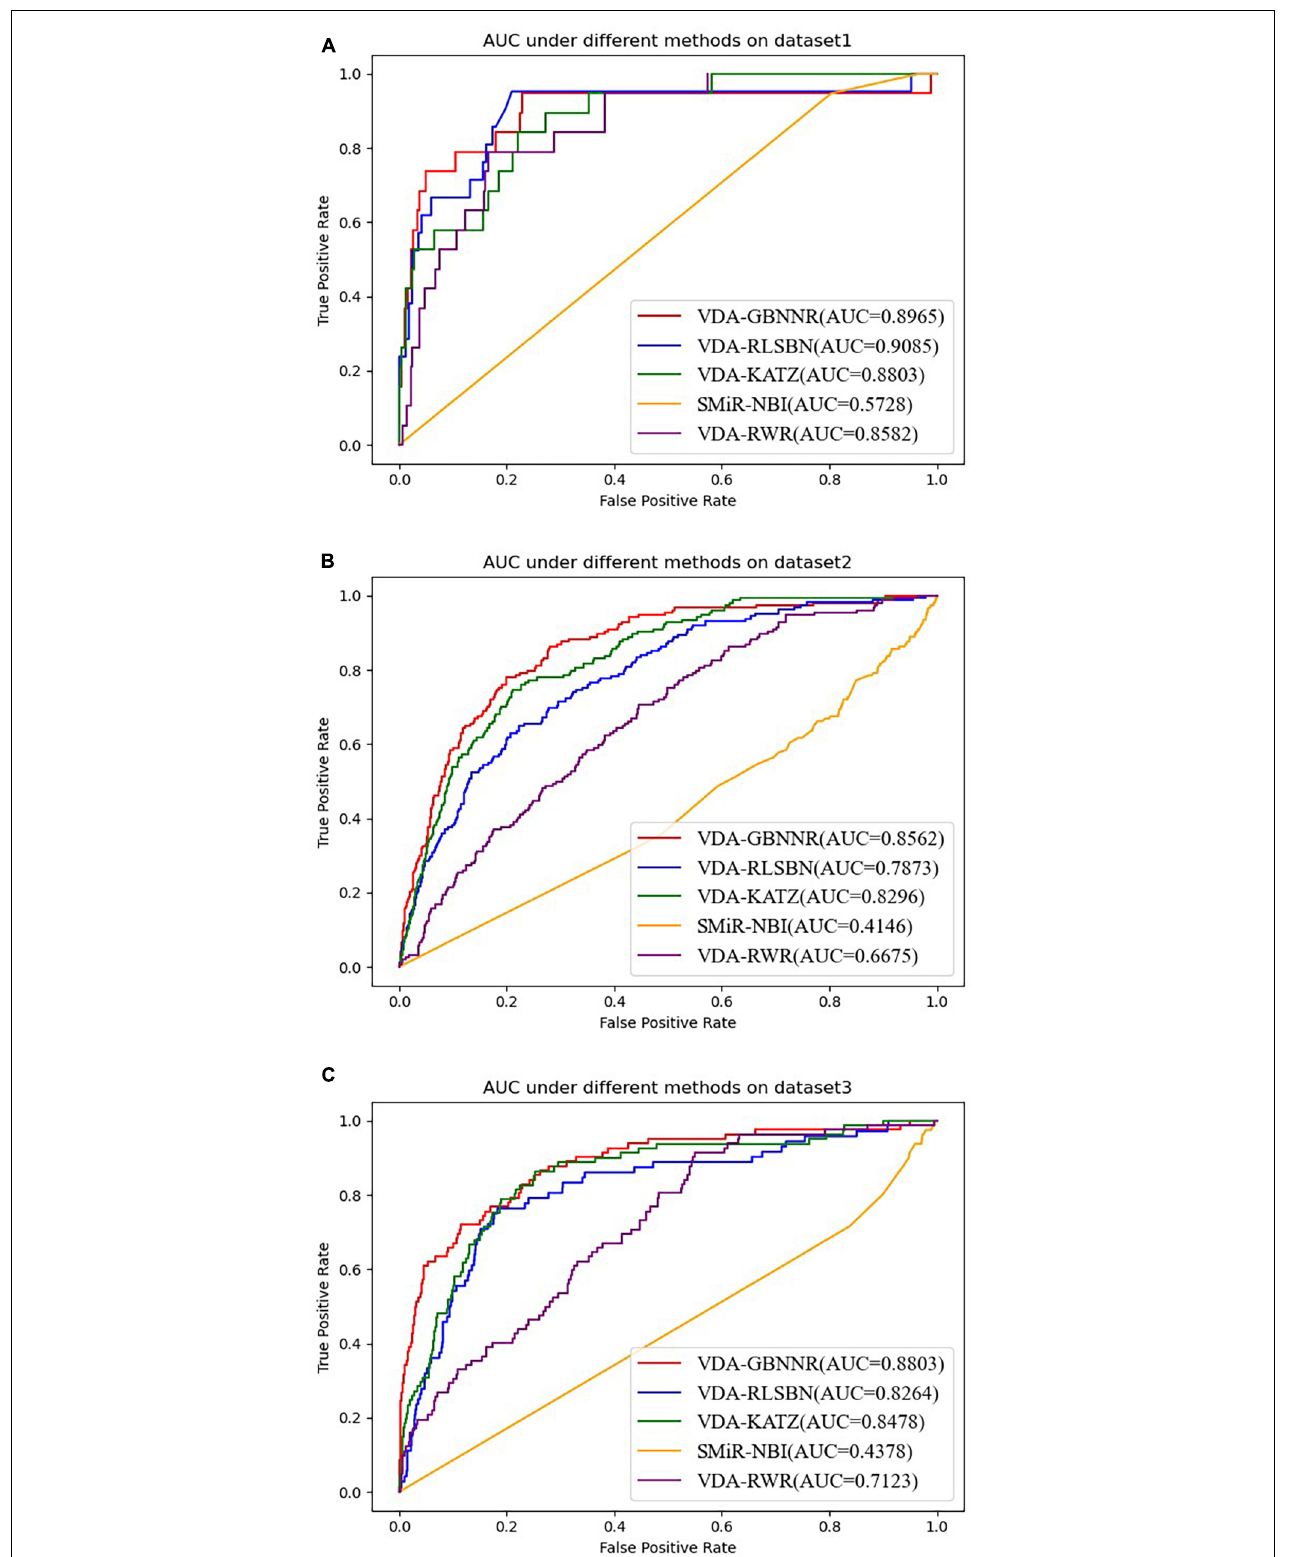
FIGURE 2 | The AUC values of five VDA prediction models on three datasets. (A) The AUC values of five VDA prediction models on dataset 1. (B) The AUC values of five VDA prediction models on dataset 2. (C) The AUC values of five VDA prediction models on dataset 3.